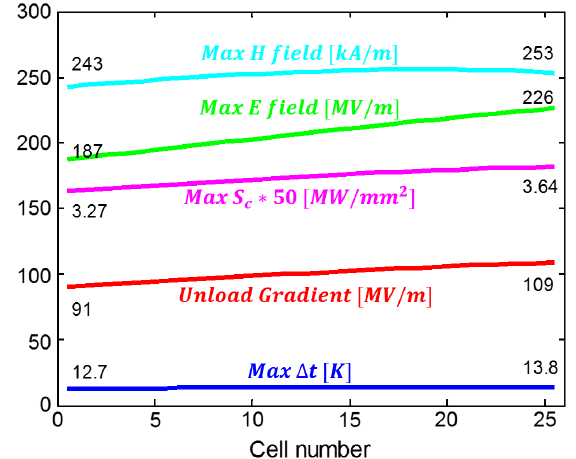
FIG. 13. Distribution of the rf parameters along the structure cells at average unloaded gradient of 100 MV = m (red: accel- erating gradient; blue: pulse temperature rise; green: maximum surface electric field; cyan: maximum surface magnetic field; magenta: maximum modified Poynting vector [15]).